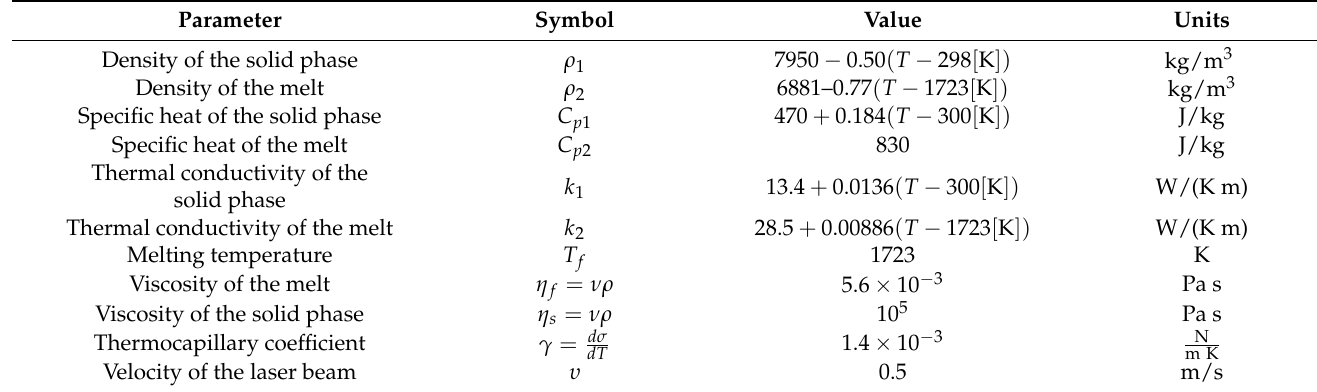
Table 1. Thermophysical and processing parameters used in simulations. Data from [37,38].